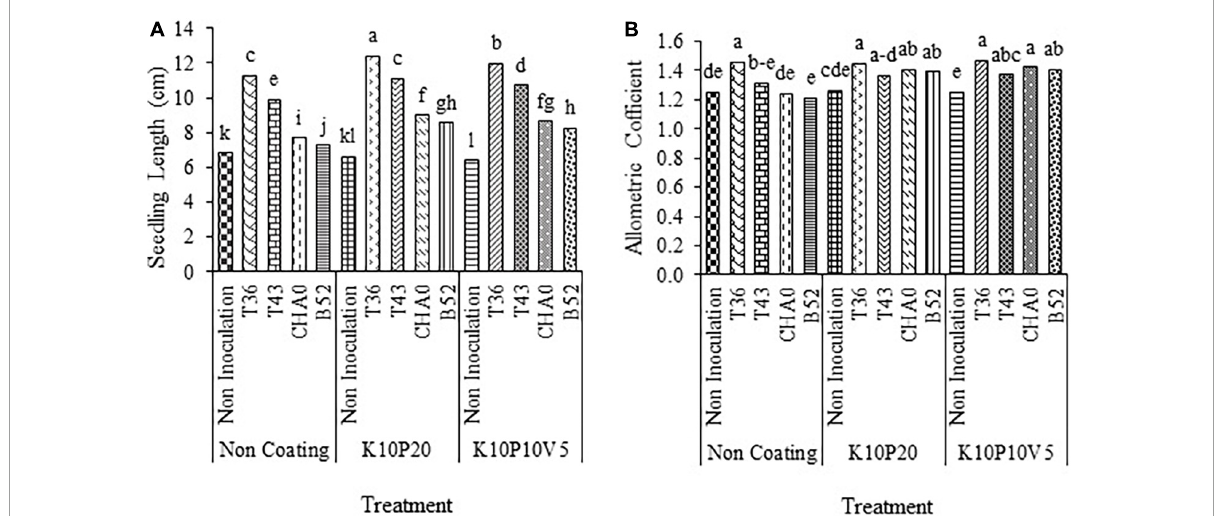
FIGURE3 Interaction of (A) seedling length (in cm) and (B) allometric coefficient of anise affected by inoculation + coating treatment. Means with the same letter are not significantly different according to the HSD test at P = 0.05. CHA0, B52 of Pseudomonas fluorescens , T36 and T43 of Trichoderma harzianum isolates. K, kaolin; V, vermiculite; P, perlite.